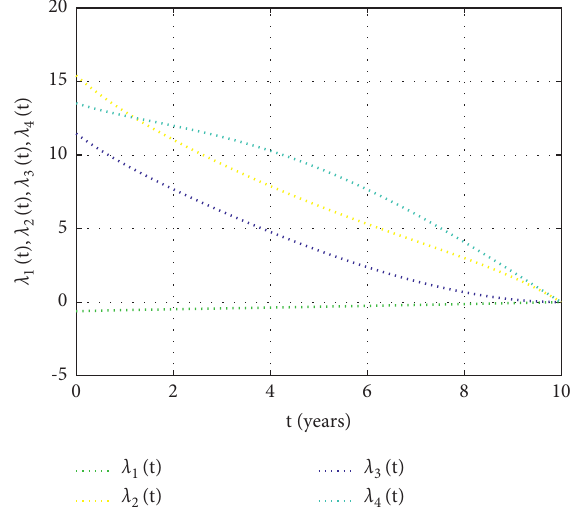
Figure 9: Simulation of susceptible population size without and with